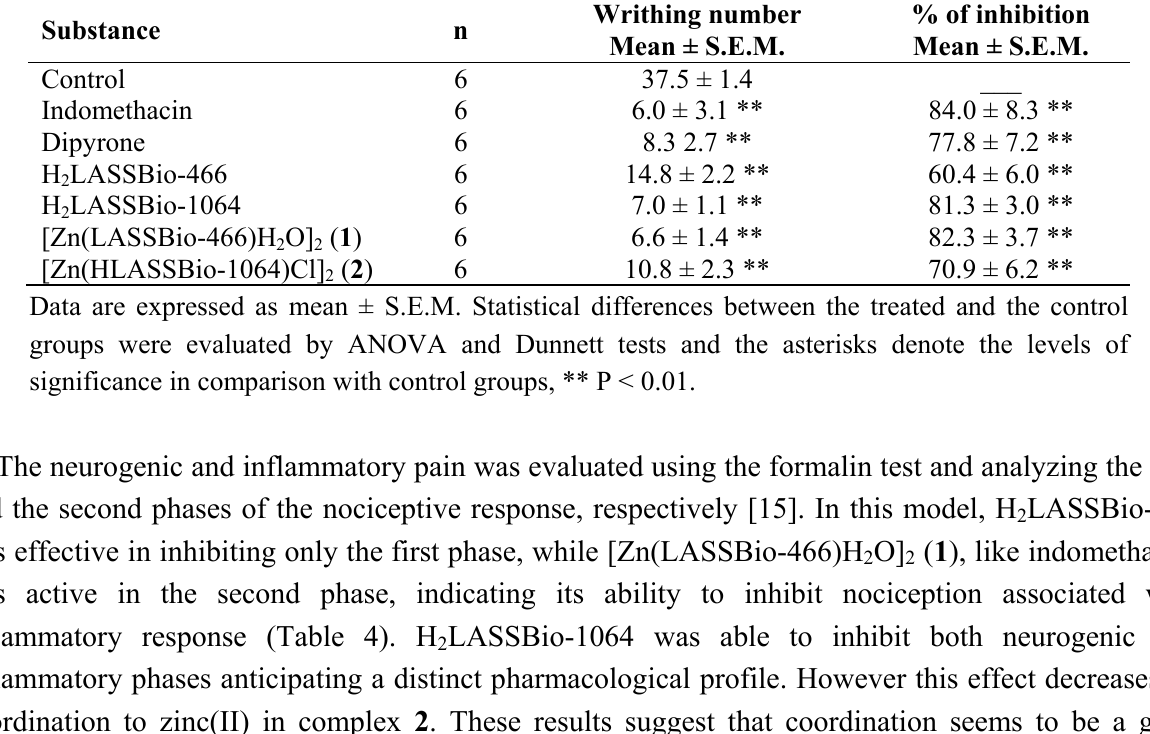
LASSBio-1064, their zinc(II) 2